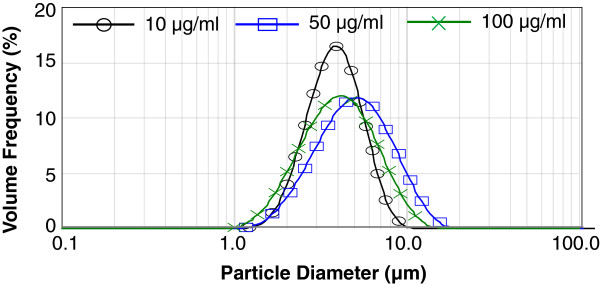
Measured using laser diffraction (Spraytec, Malvern, UK), the size distribution of nebulized droplets using SAW at 30 MHz and 1 W of applied power from an aqueous suspensions of 10, 50 and
100 μ
g/ml of pDNA indicates droplet size distributions generally less than 5 
μ
m, useful for deep lung deposition.